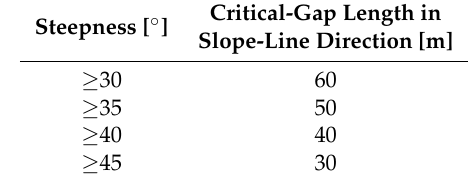
Table 1. Critical-gap lengths for avalanche release proposed by the Swiss guidelines (applies to all forest